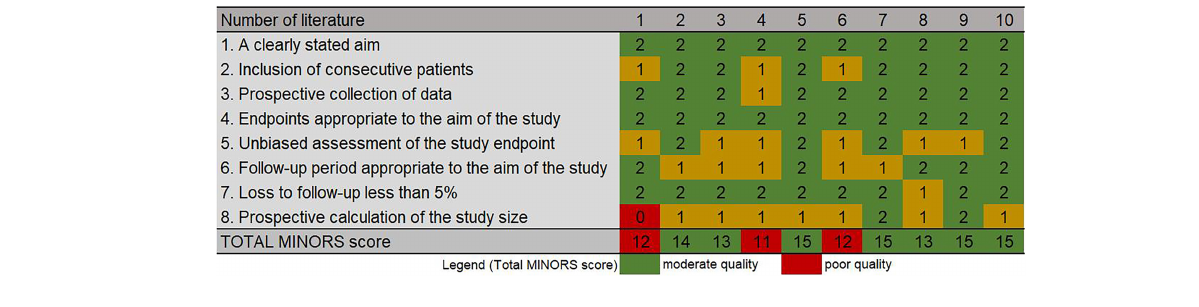
FIGURE 2 | Risk of bias graph for each included